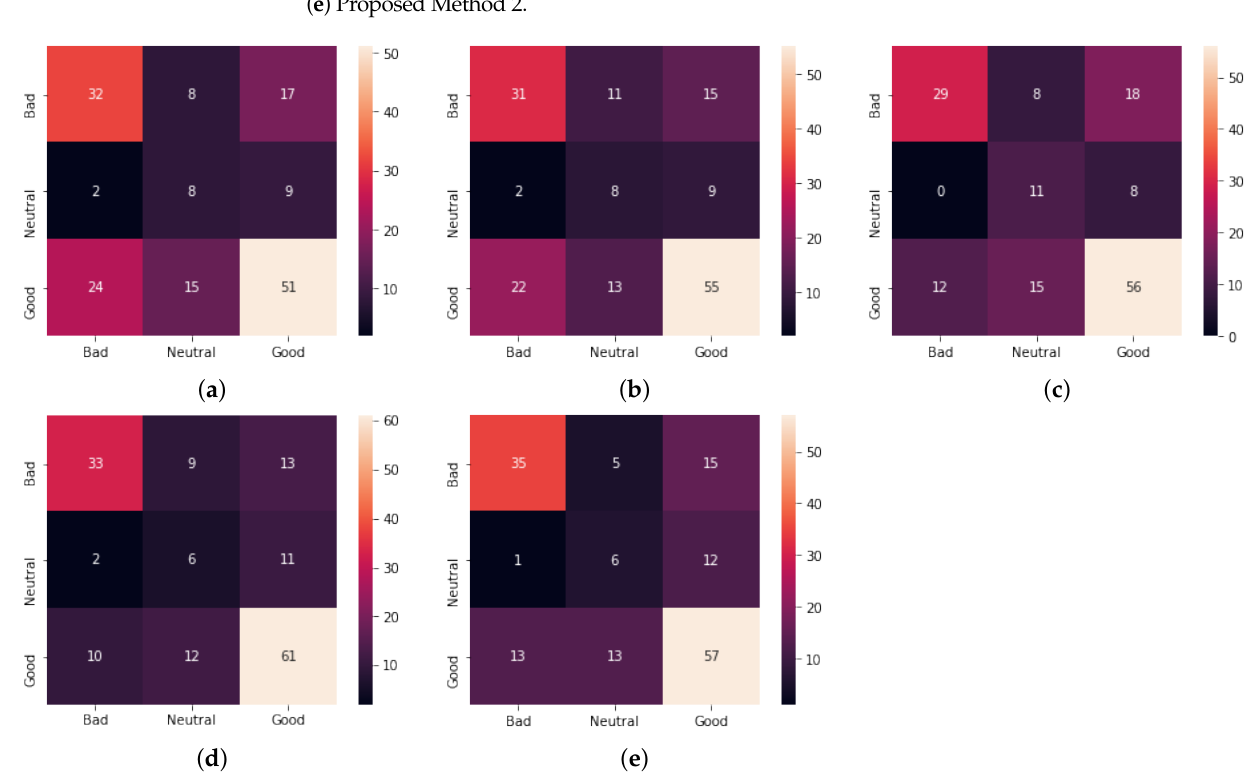
Figure 7. Confusion matrix for the five methods for the physical stress estimation at night (NQ). ( a ) Baseline Method 1; ( b ) Baseline Method 2; ( c ) Previous method [26]; ( d ) Proposed Method 1; ( e ) Proposed Method